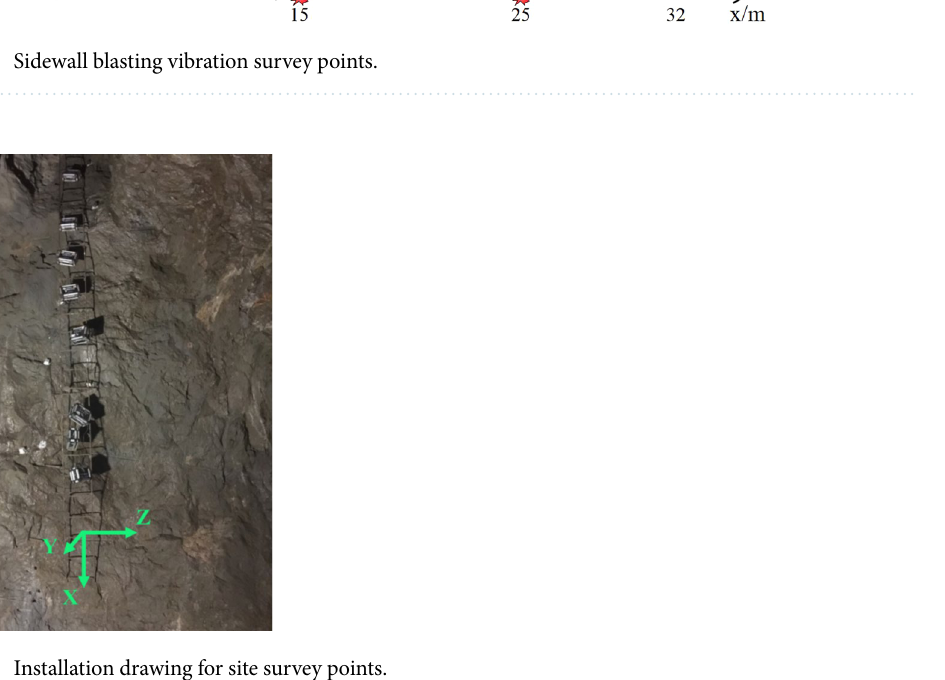
Figure 3. Installation drawing for site survey